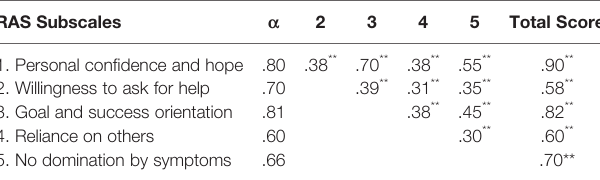
TABLE 2 | Internal consistency (Cranach ’ s a ) and intercorrelations between the RAS scales. RAS Subscales